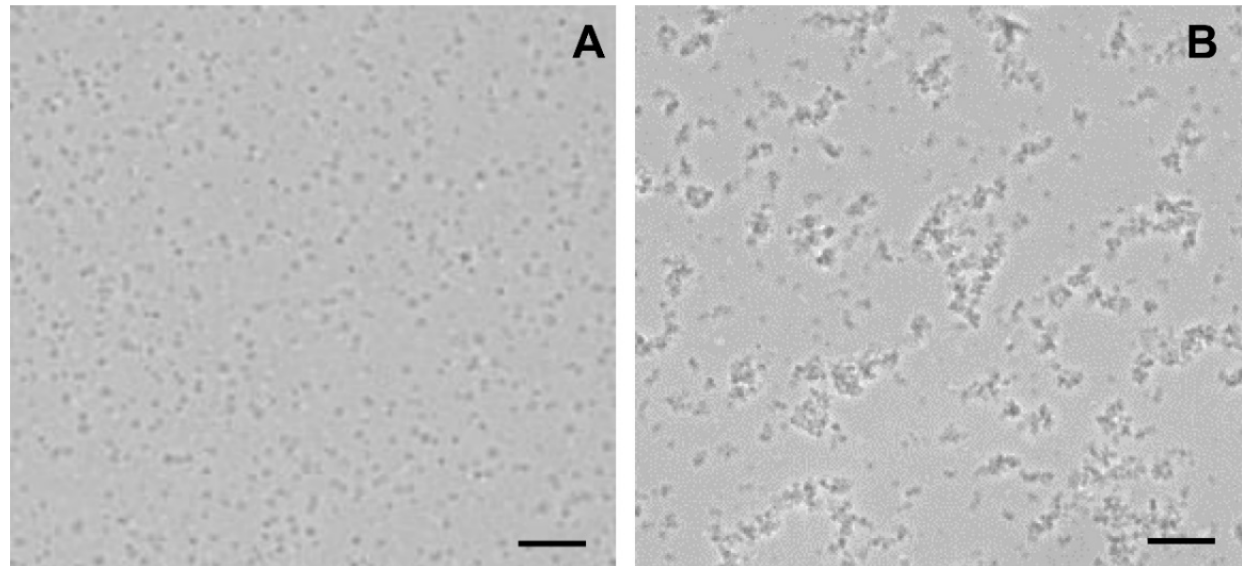
Figure 5. Light microscopy images of rat liver mitochondria incubated with F16-betulin conjugate. Panel ( A ) shows control sample (without additions). Panel ( B ) shows a sample of mitochondria captured after incubation with 30 µ M conjugate. Typical images are presented in two sets for each experimental condition. Scale bar is 10 µ